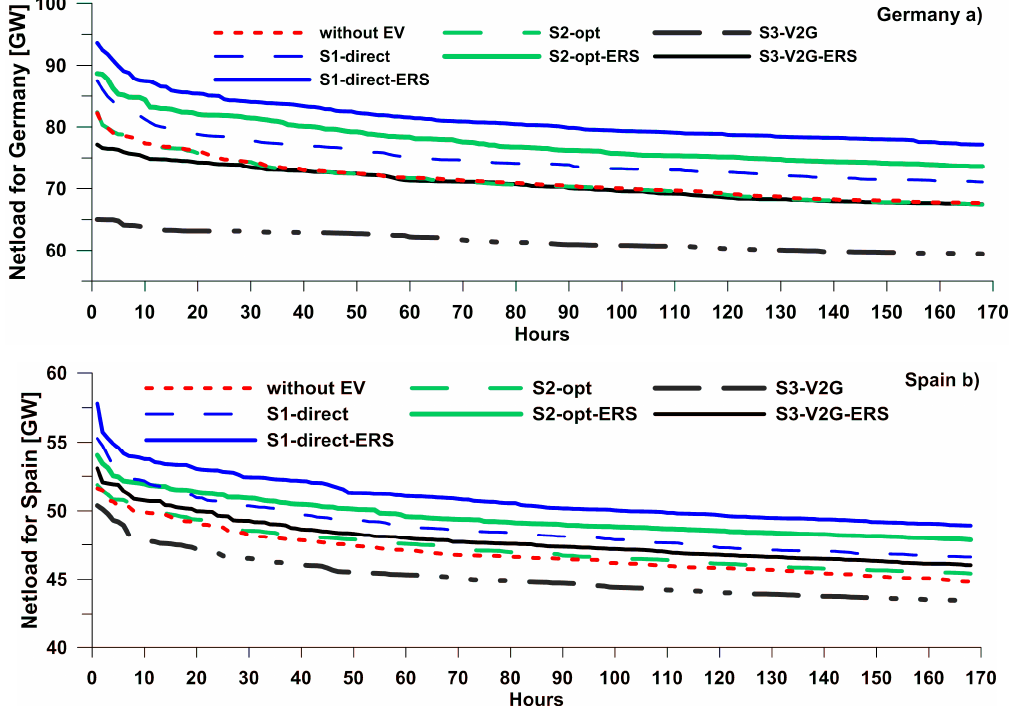
Figure 5. The net-load curves in Year 2030 sorted with respect to the 168 h with the highest net loads in: ( a ) Germany; and ( b ) Spain.